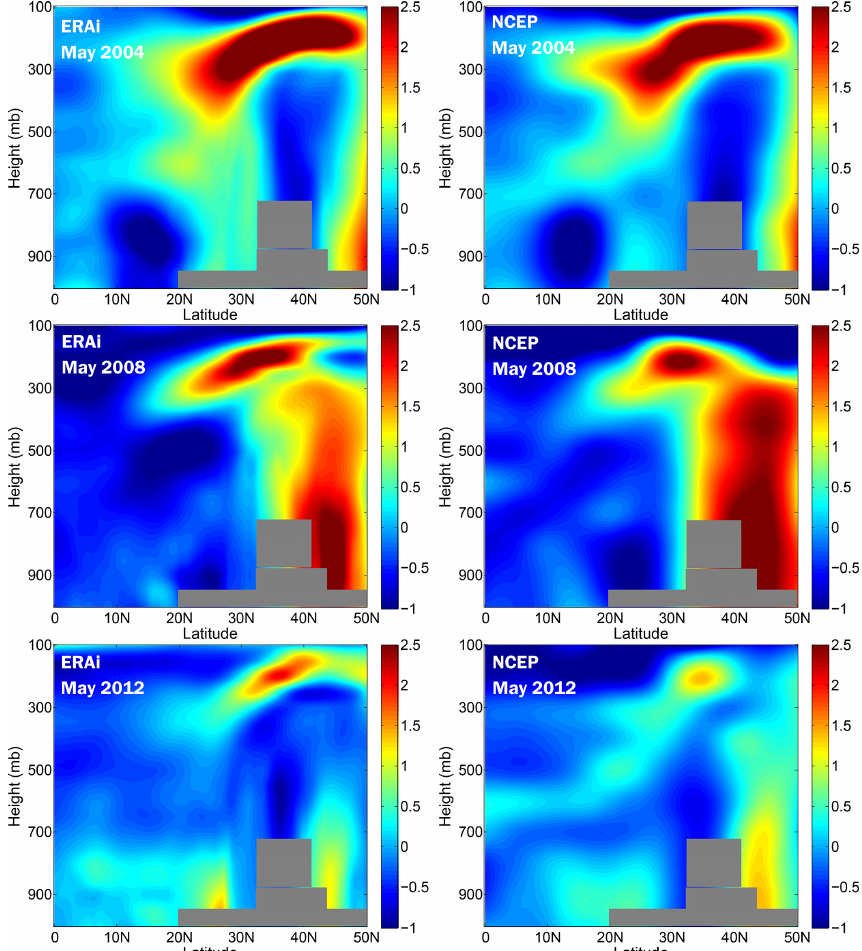
Figure 7. Latitude–height distribution of temperature anomaly ( ◦ C) from ERAi (left column) and NCEP/DOE-R2 Reanalysis (right column) over latitude sector 70 to 100 ◦ E for May of the high absorbing aerosol years: 2004 (top), 2008 (middle), 2012 (bottom). Gray shaded area is an idealized representation of elevation of the Tibetan Plateau. Anomaly is computed as difference from the mean for the years 1993–2012 for ERAi and 1981–2010 for NCEP/DOE-R2